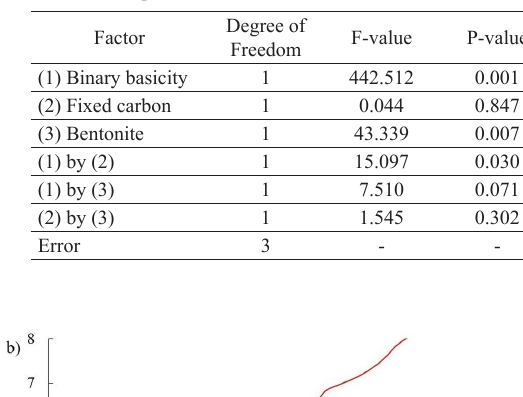
Table 5. Results of the statistical analyses for the porosity of the fired iron-ore